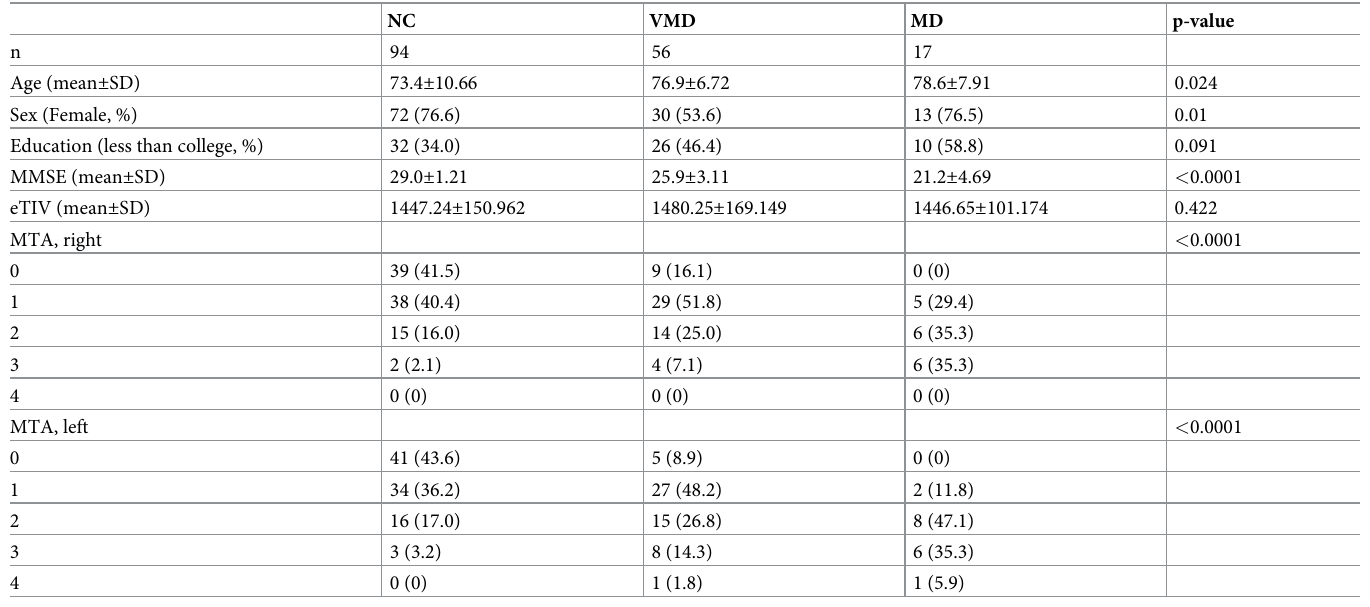
Table 1. Demographic and baseline